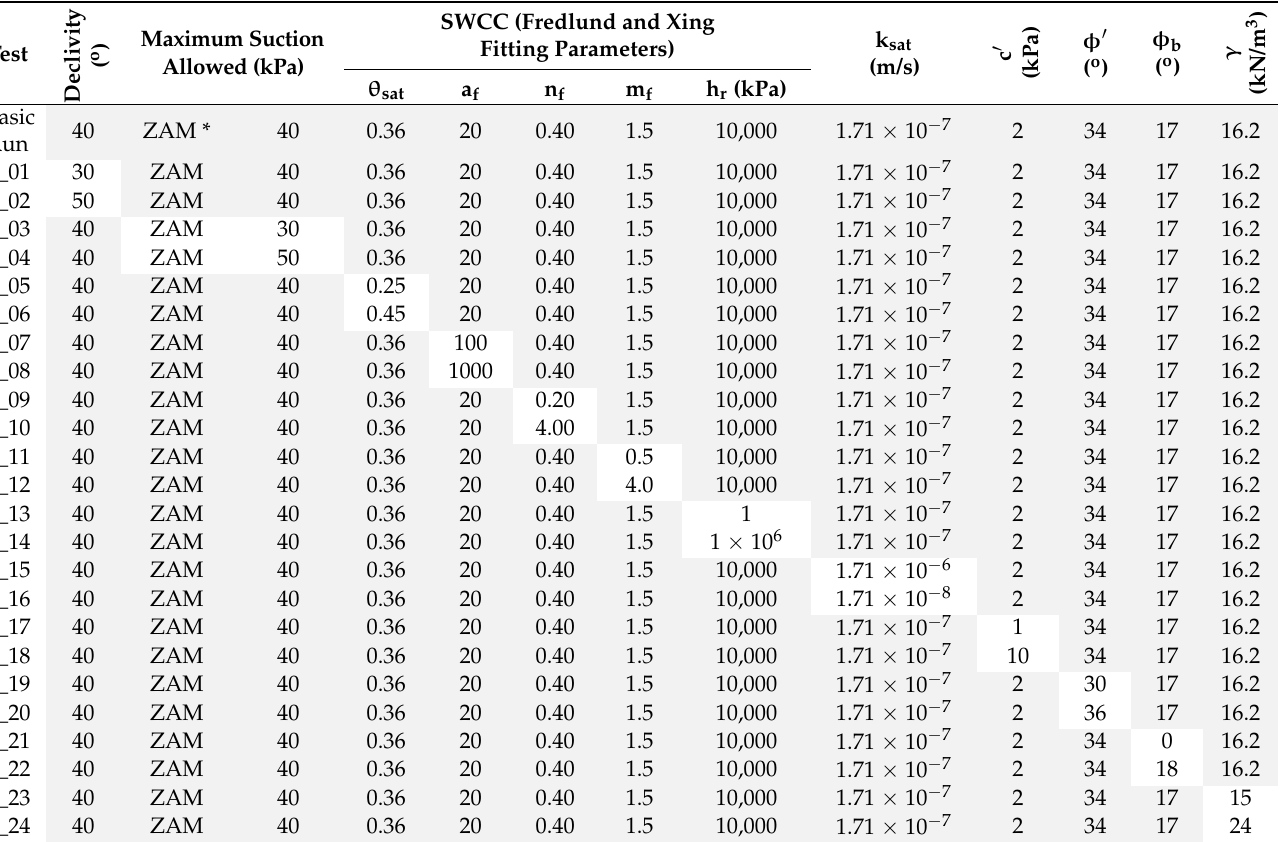
Table 2. Parametric analysis matrix (Adapted from